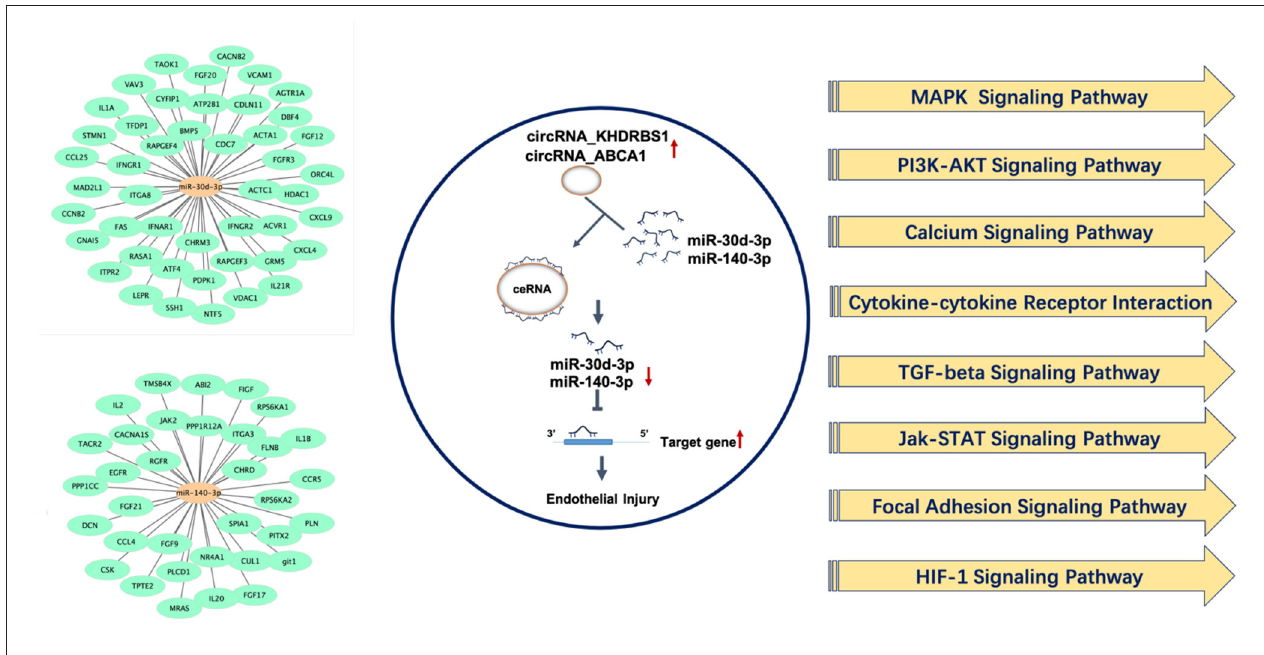
FIGURE 7 | Underlying target genes of differentially expressed circRNAs and their potential function in regulating endothelial injury and